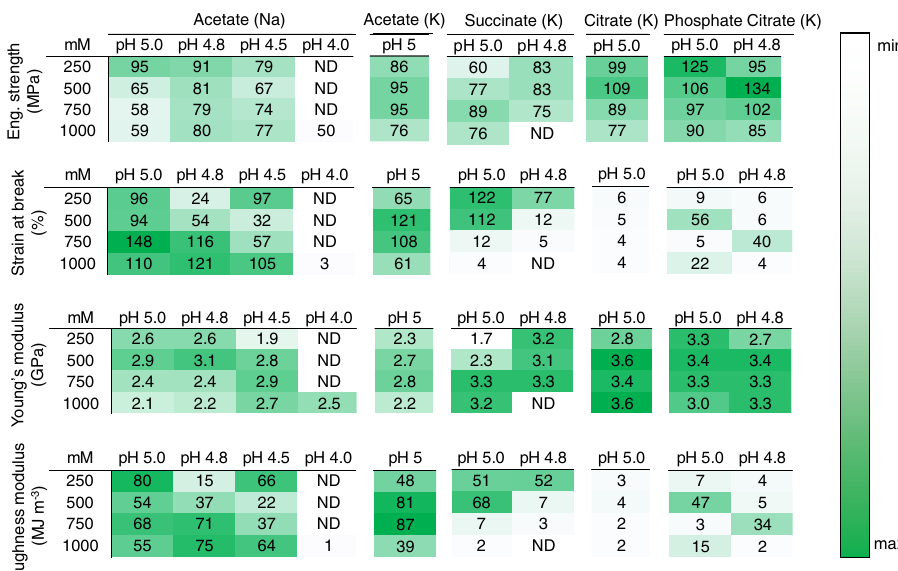
Fig. 4 Mechanical properties of NT2RepCT fi bers spun with a variety of buffers. For better orientation, the values were colored according to a gradient from white (low) to (high (dark green)). ND (not de fi ned) designates buffers that could not produce enough fi bers for tensile testing. The values shown here represent the average of n ≥ 10 measurement. The same table but with ±one standard deviation is shown in Supplementary Fig. 7. The corresponding stress-strain curves are shown in Supplementary Figs. 8 – 12. Details regarding other spinning parameters of this experiment are found in